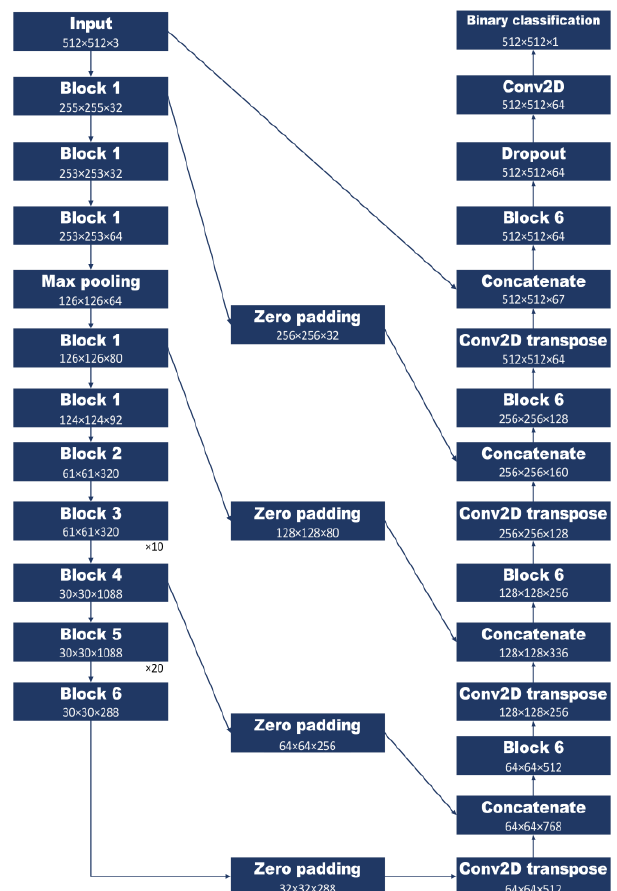
Figure 3 : An Overview of the Inception ResNet UNet architecture. The left part is a regular convolution neural network, called an encoder. The right side is called the decoder, which consists of convolution blocks, convolution transpose, and concatenation. Zero padding is utilized to get the same size for concatenating features. Details of blocks 1 to 6 have been shown in Figure 5. The output of every block is represented at the end of every section.